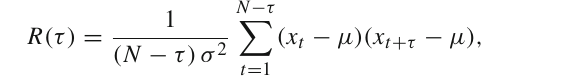
bin of the distribution of the value obtained with the ReDecay method with the value from the nominal method, divided by the naive expecta- √ N where N is the number of tion for the statistical uncertainty, σ = events in the bins. A unit Gaussian distribution is overlaid with the pull distribution to visualize their disagreement. The pull distribution has a width of 1 . 75 ± 0 . 09 indicating that uncertainties are underestimated in this illustration